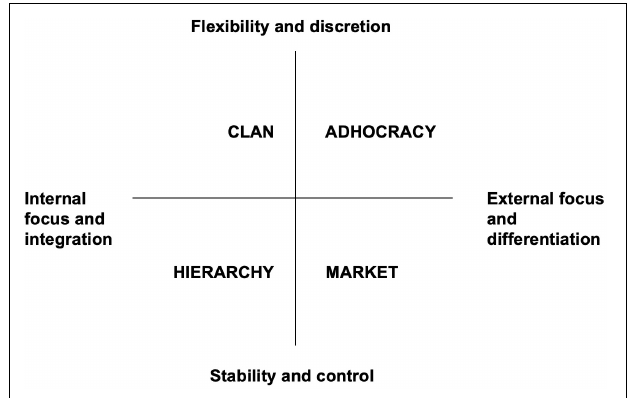
FIGURE 1 | The culture model as suggested by Cameron and Quinn (1999,